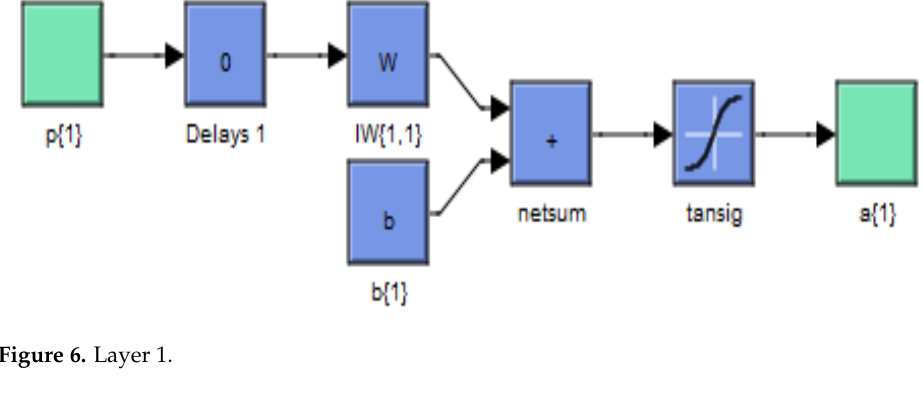
Figure 6. Layer 1. Figure 6. Layer